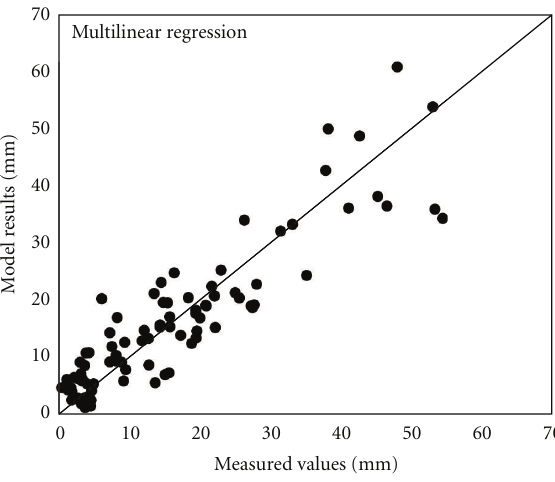
Figure 3: Comparison plot for MLR model.